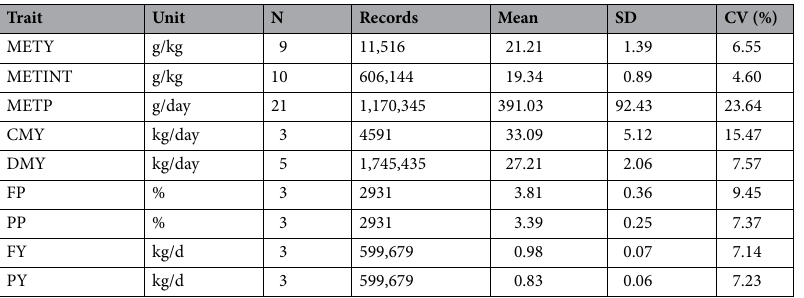
Table 2. Number of literature estimates (N), measurement units (Unit), the total number of records (Records), weighted mean, standard deviation (SD), and the coefficient of variation (CV) for methane emission traits, milk yield, and composition of dairy cows. METY, Methane yield; METINT, Methane intensity; METP, Methane production; CMY, Corrected milk yield for fat, protein, and or energy; DMY, Daily milk yield; FP, Fat percentage of milk; PP, Protein percentage of milk; FY, Milk fat yield; PY, Milk protein yield.